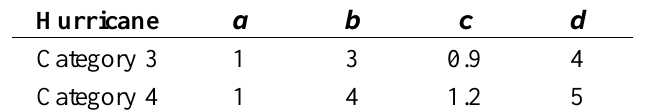
Table 2. Empirical coefficients for Xu and Huang [17] synthetic storm surge hydrograph.